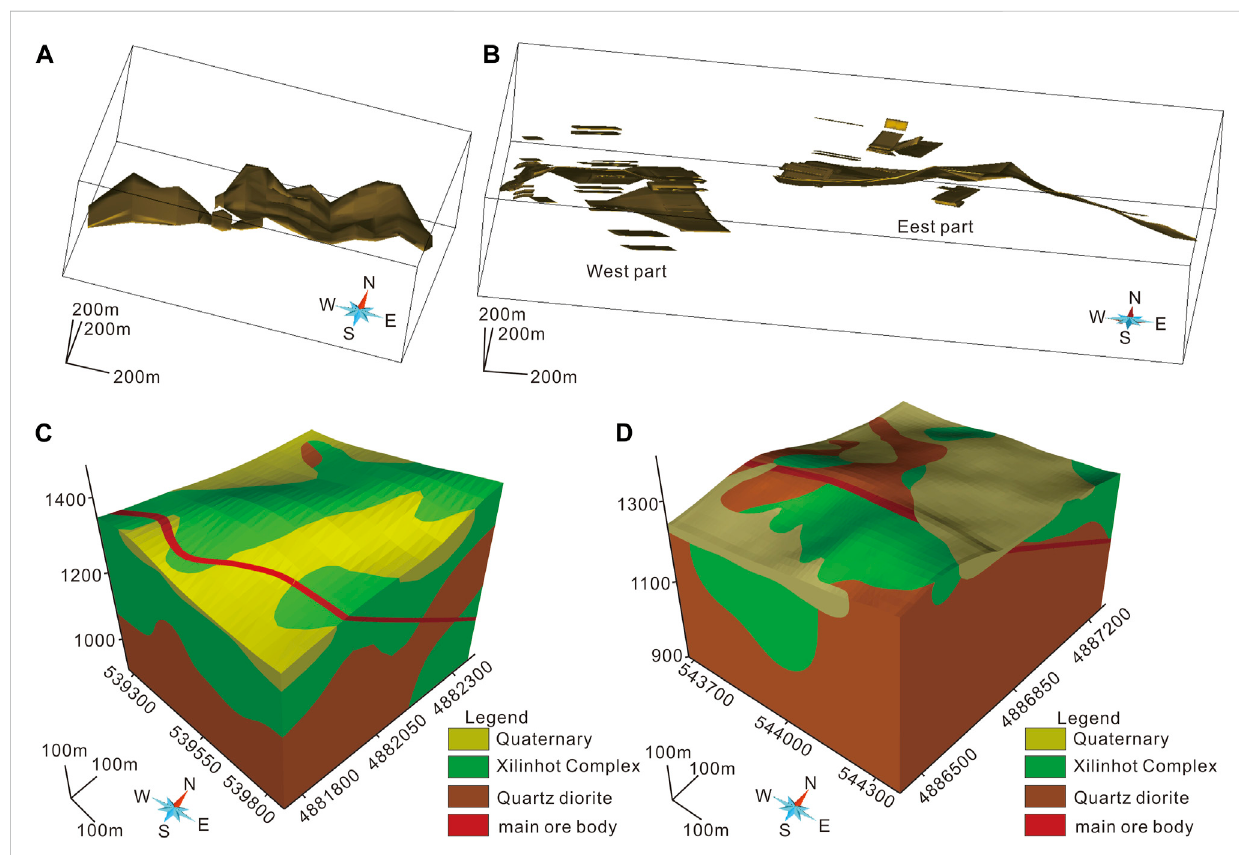
FIGURE 3 3Dmodelofthemajororebodiesof (A) theWeilasituoCu-Zndeposit; (B) theBairendabaAg-Pb-Zndeposit.3Dgeologicalmodelofkeyzonesof (C) the Weilasituo Cu-Zn deposit (D) the Bairendaba Ag-Pb-Zn